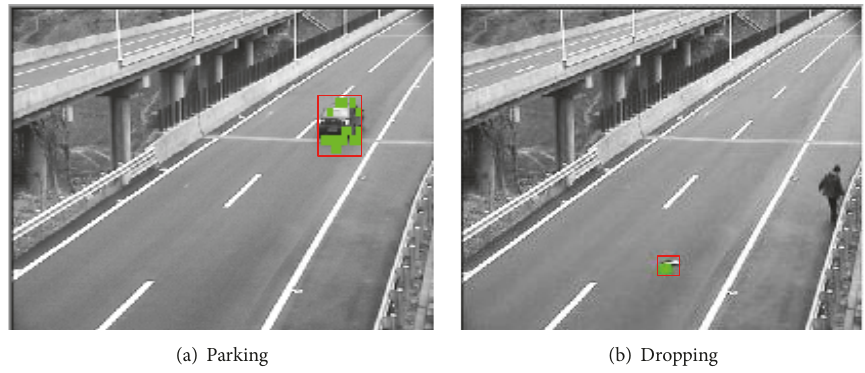
Figure 28: Improved